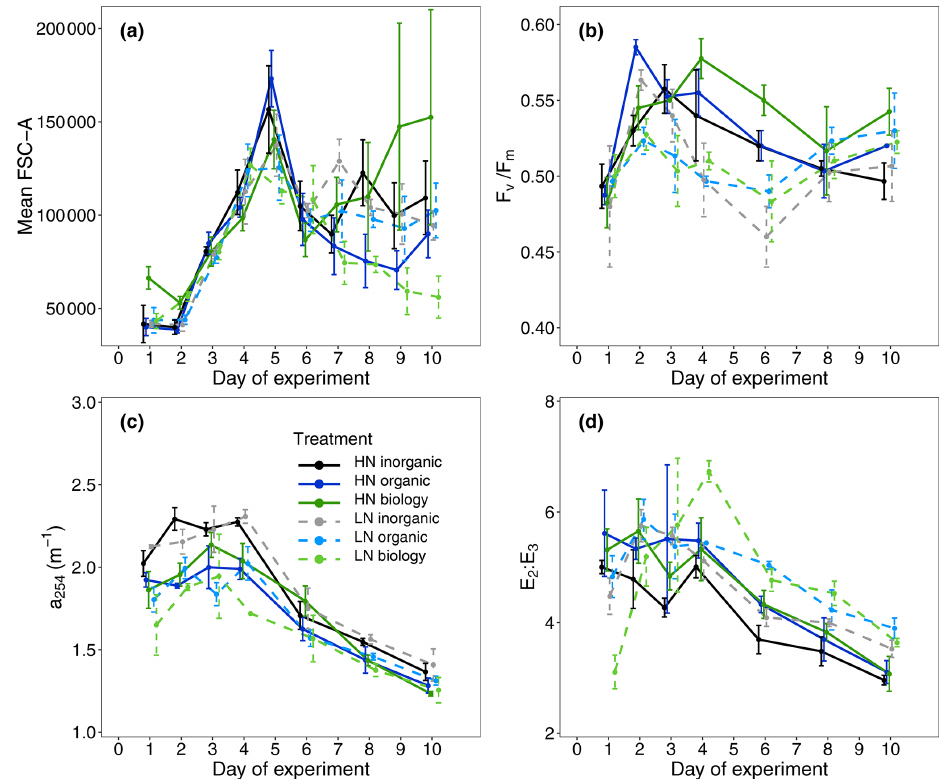
Figure 3. (a) Mean forward scatter (FSC-A) from flow cytometric analyses as a proxy of relative phytoplankton cell size during the study period, (b) maximum photochemical efficiency ( F v /F m ), (c) absorption coefficient at 254nm ( a 254 ) used as a proxy for DOC concentration and (d) the ratio of the absorption coefficients at 250 and 365nm ( E 2 : E 3 ) as an indicator of DOM molecular